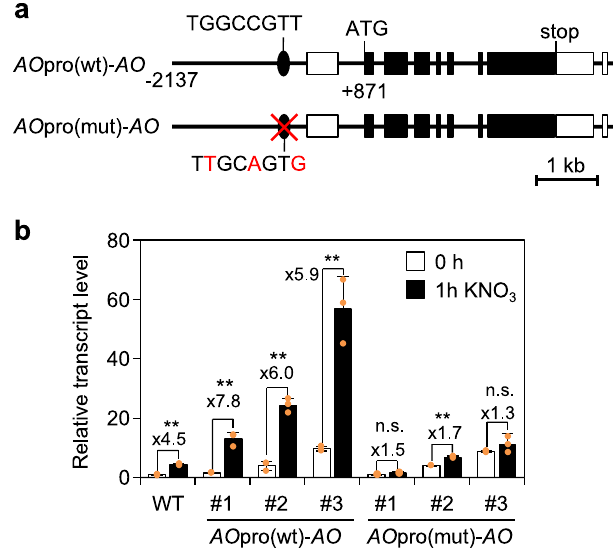
Fig. 3 NLP-binding site-dependent induction of AO expression by nitrate in planta . a Schematic representation of AO pro(wt)- AO and AO pro(mut)- AO constructs introduced into the ao mutant. The construct contained a 6753 bp sequence of the AO locus (from 2,137 bp upstream of the transcription start site to 869 bp downstream of the stop codon). In the AO pro(mut)- AO construct, the NLP-binding sequence was mutated. White and black boxes indicate untranslated and translated regions, respectively. b RT-qPCR analysis of nitrate-induced AO expression in 4-day-old seedlings of the WT and three independent transgenic lines (#1, #2, and #3). The seedlings were treated with 10 mM KNO 3 for 1 h. The expression level of AO in WT seedlings not exposed to the nitrate treatment was set to 1. Data represent mean ± SD ( n = 3). Induction folds are indicated. Asterisks indicate signi fi cant differences between seedlings treated with and without nitrate (Welch ’ s t -test; * P ≤ 0.05, ** P ≤